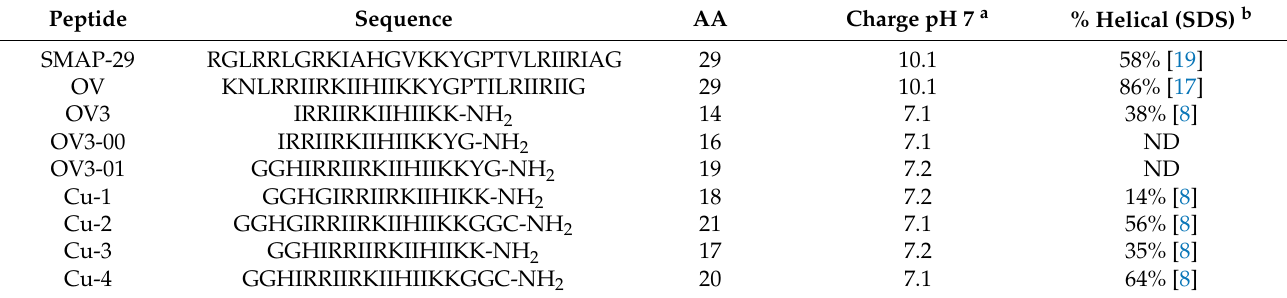
Table 1. SMAP-29 derivatives used in this study and others with sequences and defining charac- teristics. a Estimated charge calculated from Innovagen’s peptide property calculator. b The helical activity of peptides as previously reported in the referenced manuscripts. ND: not determined.